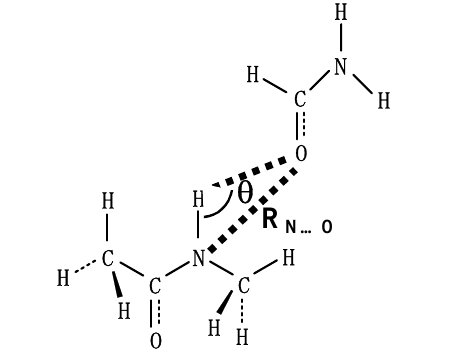
OCH C Figure 1. A diagram of an N-methylacetamide hydrogen-bonded with a formamide with the hydrogen- bond length R between the amide hydrogen and amide carbonyl oxygen atoms, and the hydrogen- N…O bond angle θ which is defined to be 180 o for the linear hydrogen bond(N-H…O=C).